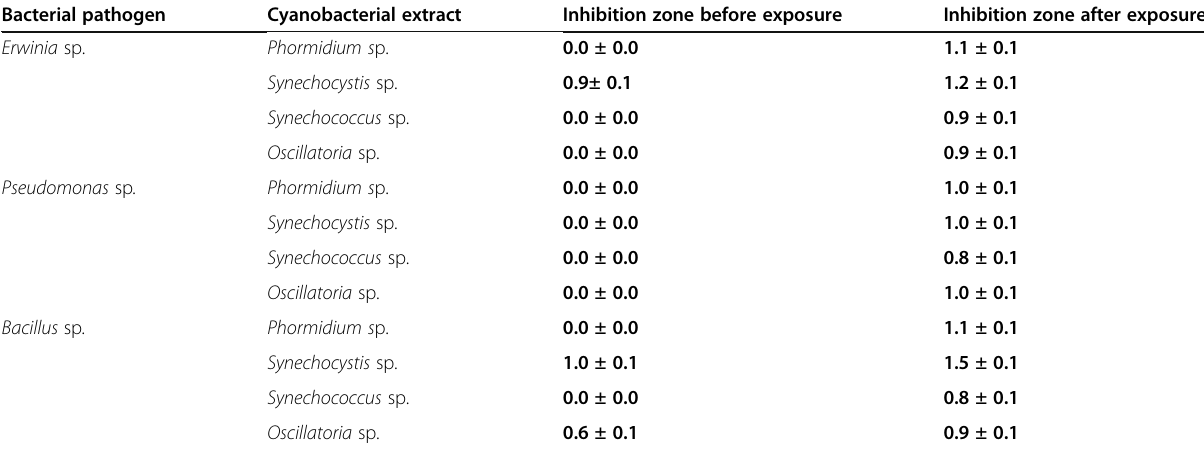
Table 2 The inhibition zone before and after UV exposure Bacterial pathogen Cyanobacterial extract Inhibition zone before exposure Inhibition zone after exposure Erwinia sp.